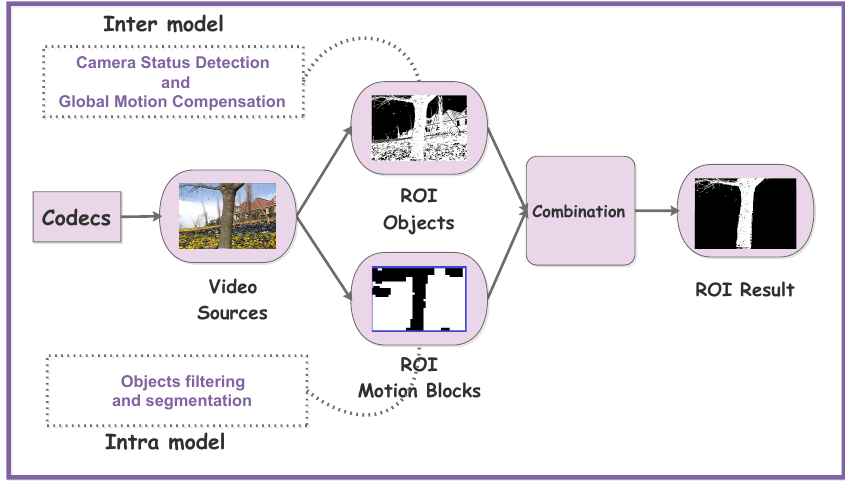
Figure 1. Basic structure of ROI Detection